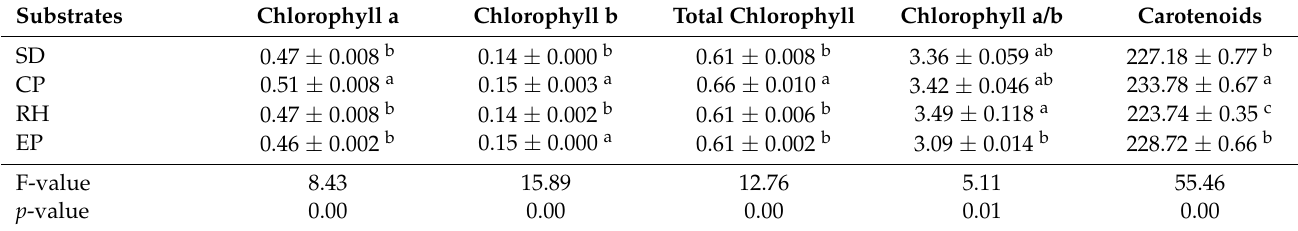
Table 5. Chlorophyll and carotenoid content of leaves under different growing media cultures in lettuce. Substrates